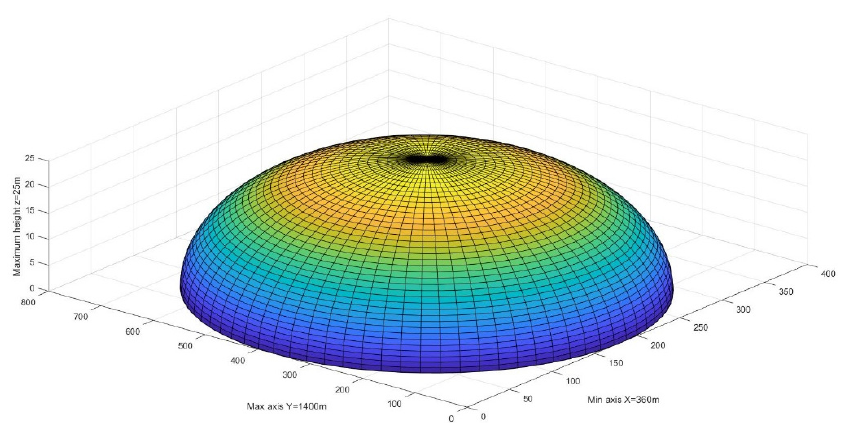
Figure 13. Three-dimensional plane view of the landslide geometric shape.